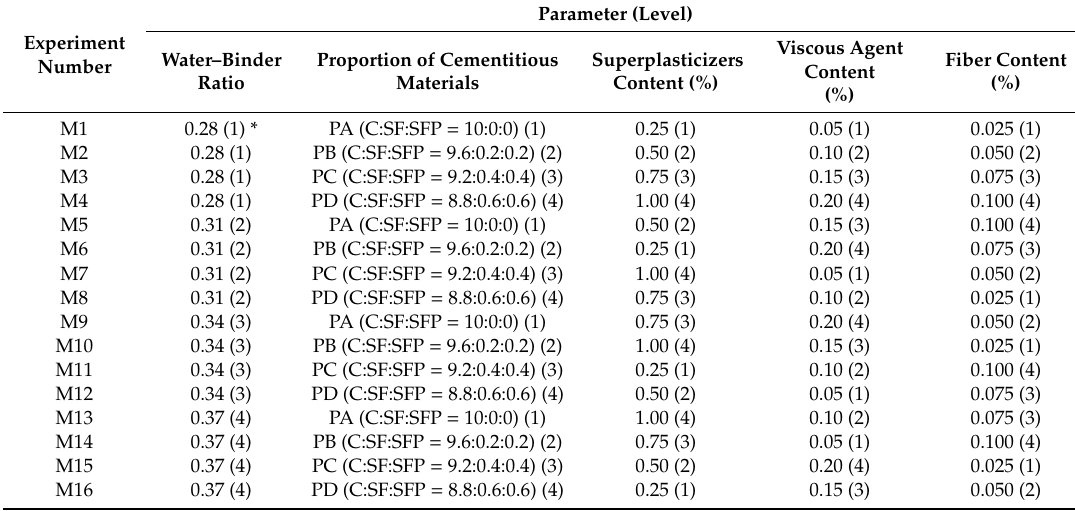
Table 4. L 16 (4 5 ) orthogonal array for matrix.